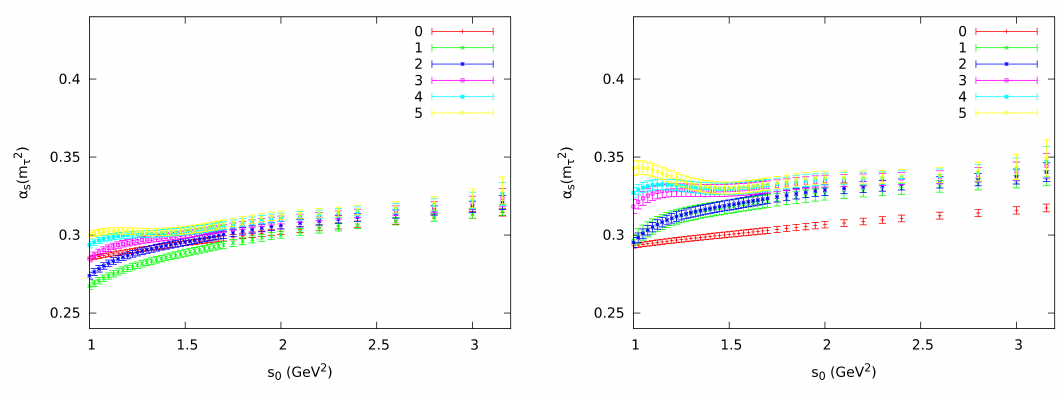
( m 2 ) determinations with FOPT (left) and CIPT (right), at different Figure 3: α τ s values of s and from different ( V + A ) A ( 2, m ) ( s 0 non-perturbative effects [ 16 ] . Only experimental uncertainties are